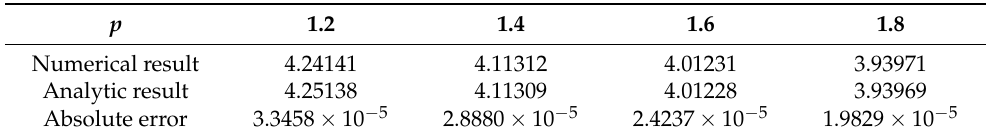
Table 5. Expected value E [ X T ] with different orders p .